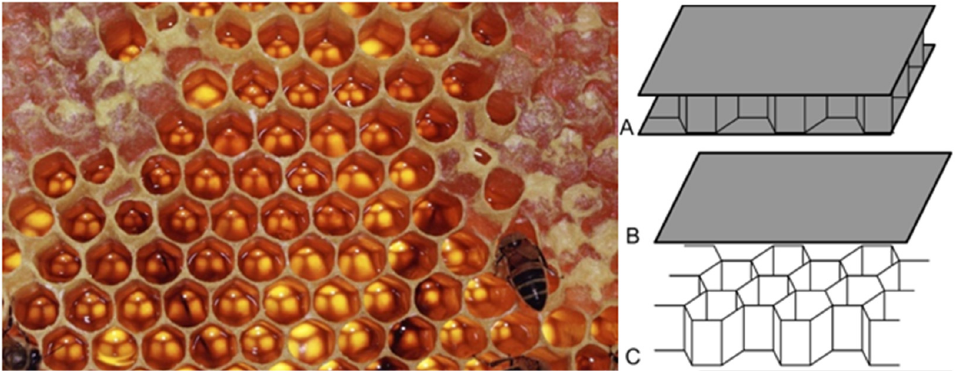
Figure 8. Honeycomb ( left ) and the sandwich structure’s schematic view ( right ) (Source: https://en.wikipedia.org/wiki/Sandwich-structured_composite).